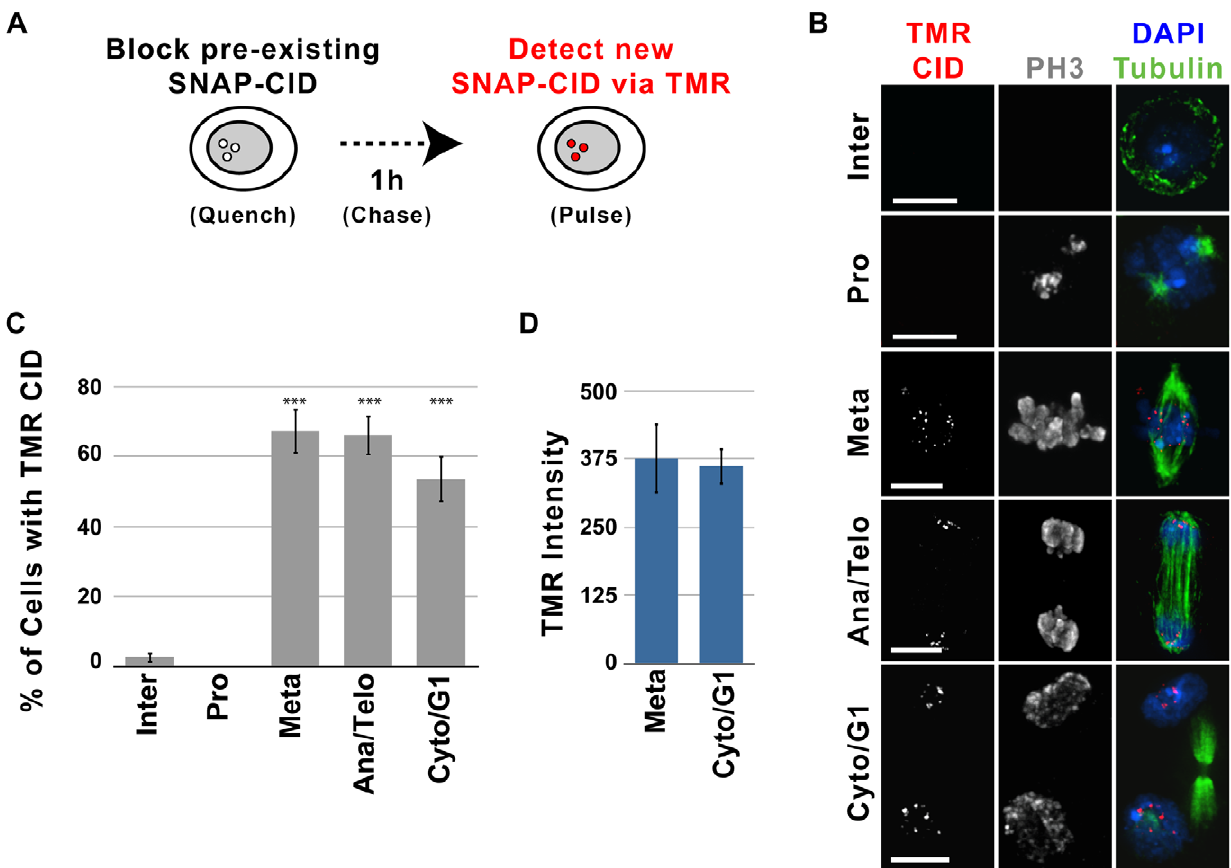
Figure 2. Recruitment of new CID occurs during metaphase in S2 cells. A) Experimental design for monitoring recruitment of new SNAP-CID during mitosis. Clonal S2 SNAP-CID cells were incubated with 12 m M BTP-block to render all pre-existing CID unable to react with TMR. After extensive washes, cells were harvested at different times following the block, and newly-synthesized CID was detected by incubation with TMR. B) Representative images showing recruitment of TMR-CID (red) 2 h after the BTP-block. Centromeric TMR-CID is rarely observed in interphase (Inter), but it is visible in metaphase (Meta), anaphase/telophase (Ana/Telo) and cytokinesis/G1 (Cyto/G1). IF with anti-tubulin (green), anti-phospho H3 (gray), and DAPI (blue) was used to identify specific mitotic stages. Bar=5 m m. C) Average percent of interphase (n=113), prophase (n=37), metaphase (n=55), anaphase/telophase (n=29), and cytokinesis/G1 (n=56) cells displaying centromeric TMR-CID 1 h following the BTP-block (X axis=cell cycle stage, Y axis=percent of cells positive for TMR labeling). New CID recruitment is visible within the first hour following the BTP-block in mitotic cells (*** p , 0.0001 compared to interphase, Fisher’s exact test). Data for different chase times are shown in Figure S2. D) Quantitative comparison of the TMR-CID intensity at centromeres in metaphase (n=32) and cytokinesis, (n=35). Cells in cytokinesis did not show a significant increase in TMR intensity (p=0.5129, Mann-Whitney test), suggesting that new CID incorporation occurs mainly in metaphase. Bars represent standard